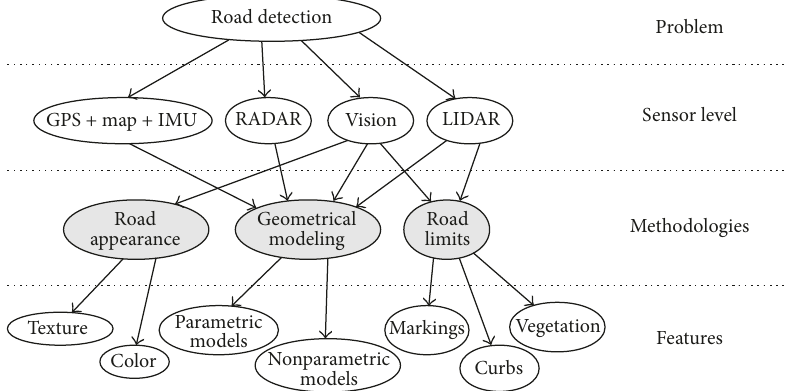
Figure 1: Classification of different road detection approaches depending on the sensor and the methodology.